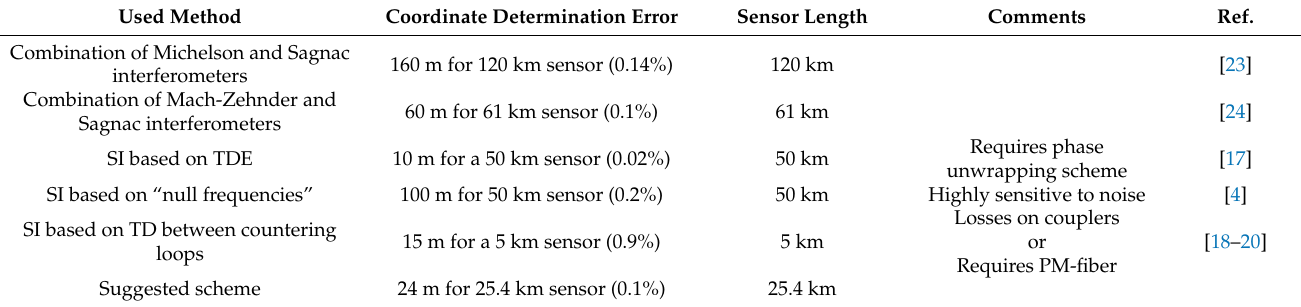
Table 3. Comparison of system parameters for reviewed